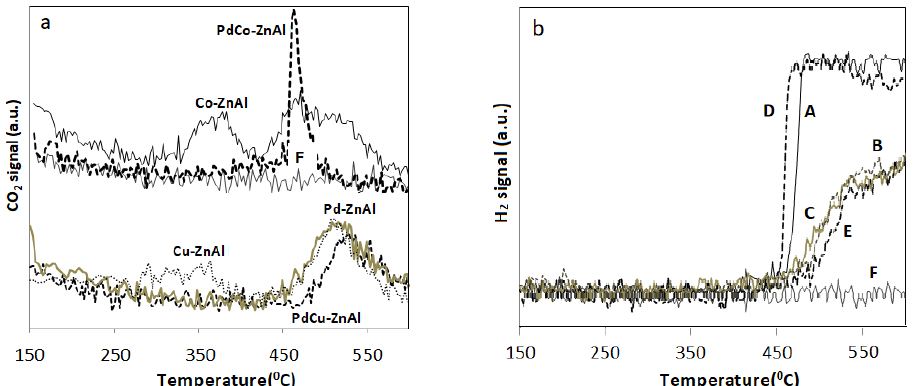
Figure 6. ( a ) CO 2 signal vs. temperature. ( b ) Signal H 2 vs. temperature. (A) Co-ZnAl; (B) Cu-ZnAl; (C) Pd-ZnAl; (D) PdCo-ZnAl; (E) PdCu-ZnAl; (F) without catalyst.